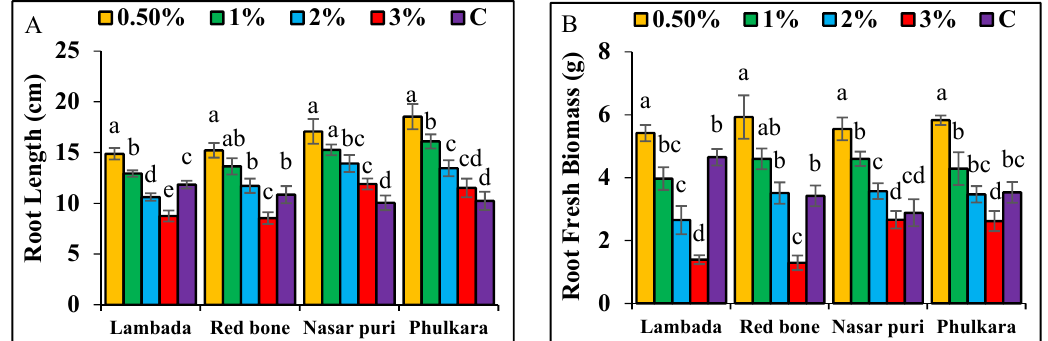
Figure 3. Root length ( A ) and fresh biomass ( B ) in onion cultivars as affected by foliar application of 0 (C = control), 0.5, 1, 2, or 3% seaweed extract. Values are means of nine replicates ± standard error. Means with different letters are significantly different from each other compared by LSD at p ≤ 0.05.